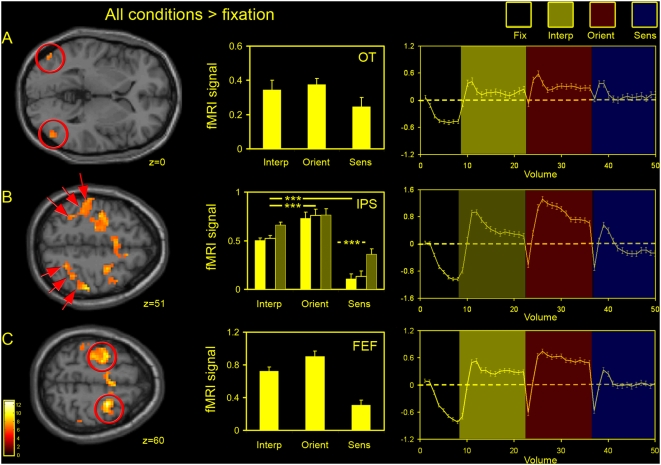
Experimental conditions compared to fixation.Clusters activated (relative to fixation) in the random effects group analysis are shown here for all conditions [left column; threshold of P<0.001 (uncorrected); see Table 1 for activated foci] along with plots of % BOLD signal change relative to fixation (centre column; group data) and the corresponding averaged time-series (right column) for the following key activated regions: (A) an occipito-temporal (OT) region, (B) the intraparietal sulcus (IPS), and (C) frontal eye fields (FEFs). Plots represent activity combined for each cluster across the two hemispheres relative to fixation. For the intraparietal sulcus (B) clusters of activity were divided into three groups bilaterally, generating three sub-regions of interest (red arrows) moving from posterior regions of the IPS towards more anterior regions. In the plot the posterior region is shown in bright yellow, the middle region in black and the more anterior region in light yellow / grey. The z coordinate (MNI) is given for each horizontal slice shown. Conditions: [Inter, interpolation; Orient, orientation; Sens, sensorimotor control]. *** P<0.001 (one-way ANOVA with Tukey's post hoc analysis).